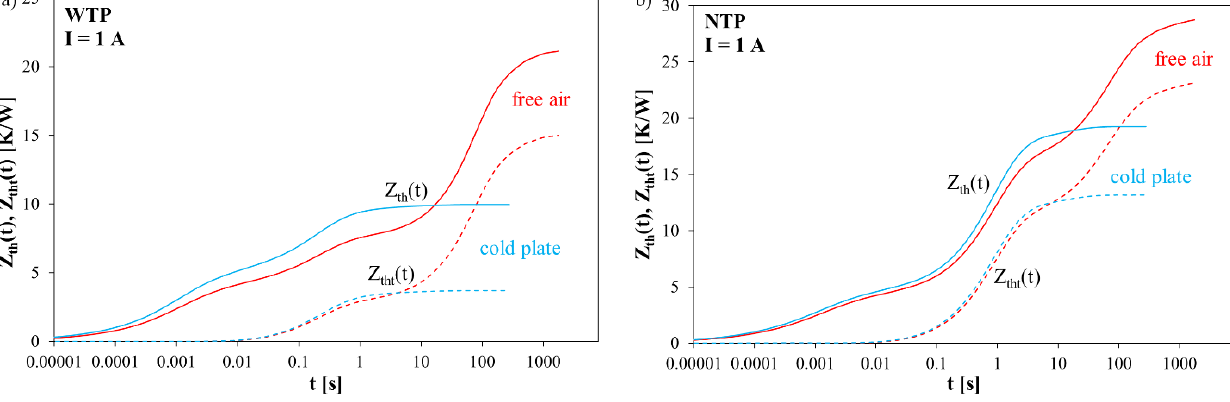
Figure 7. Spectra of thermal time constants of the tested light emitting diodes (LEDs) situated on the heat-sink ( a ) and operating without any heat-sink ( b ) obtained using the ESTYM software and the authors’ set-up.